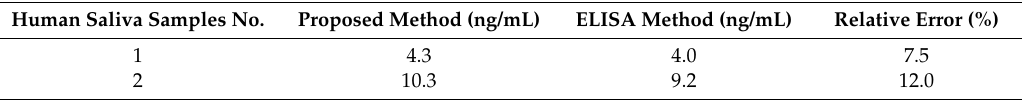
Table 2. Pepsin levels in patient saliva samples ( n = 2) obtained by the as-prepared immunosensor and the ELISA method.